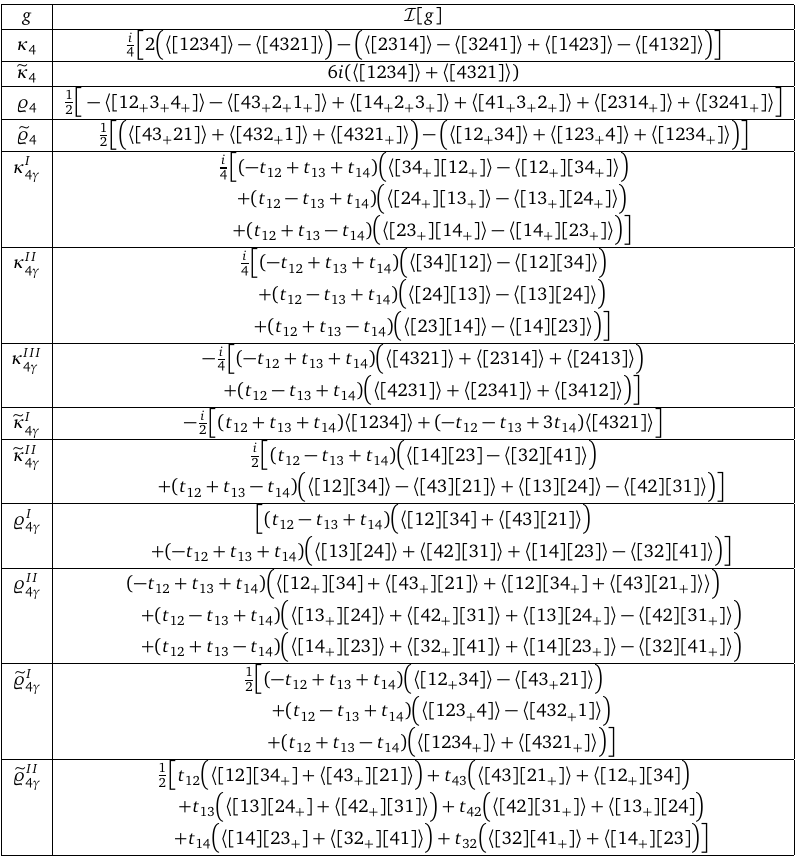
Table 6: Relations between the OTO couplings and the 4-point OTO cumulants of O ( t